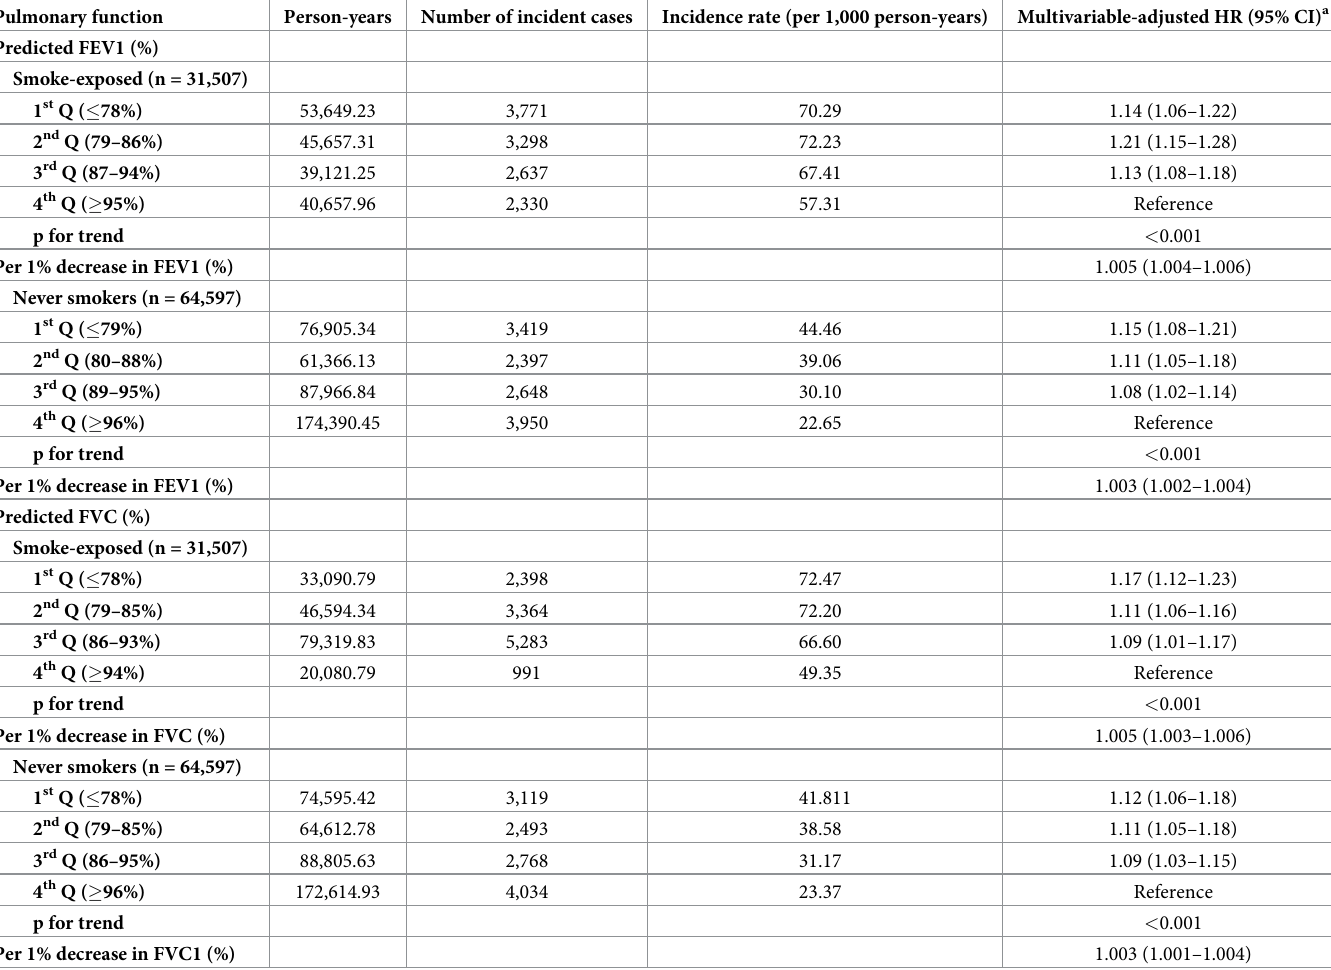
Table 4. Development of non-alcoholic fatty liver by quartiles of baseline spirometry values in smoke-exposed and never-smoker